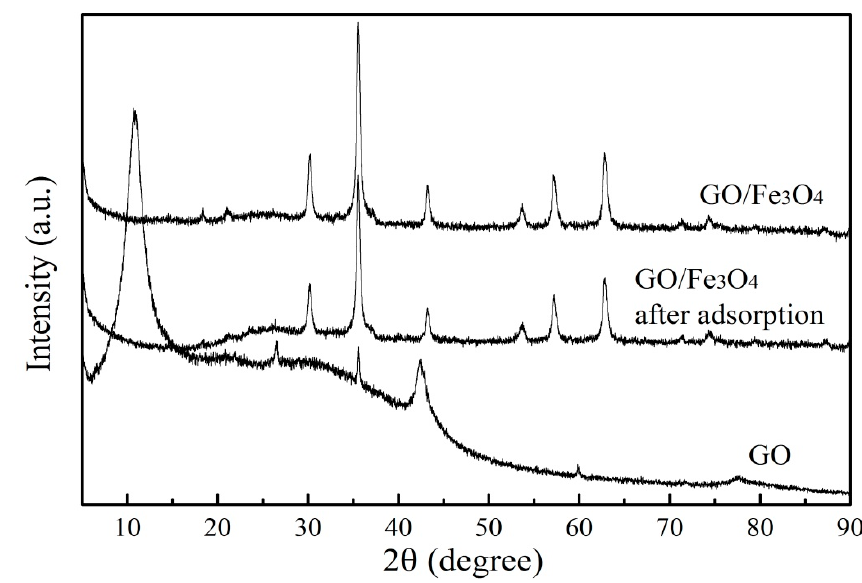
Figure 4. XRD of GO, GO / Fe 3 O 4 , and GO / Fe 3 O 4 after adsorption.